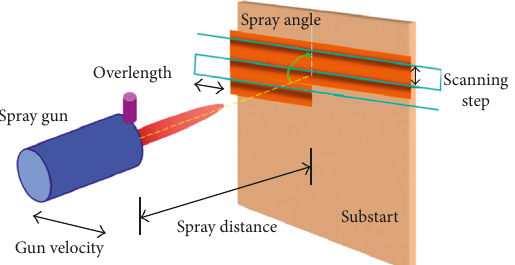
Figure 1: The kinematic parameters of cold spray